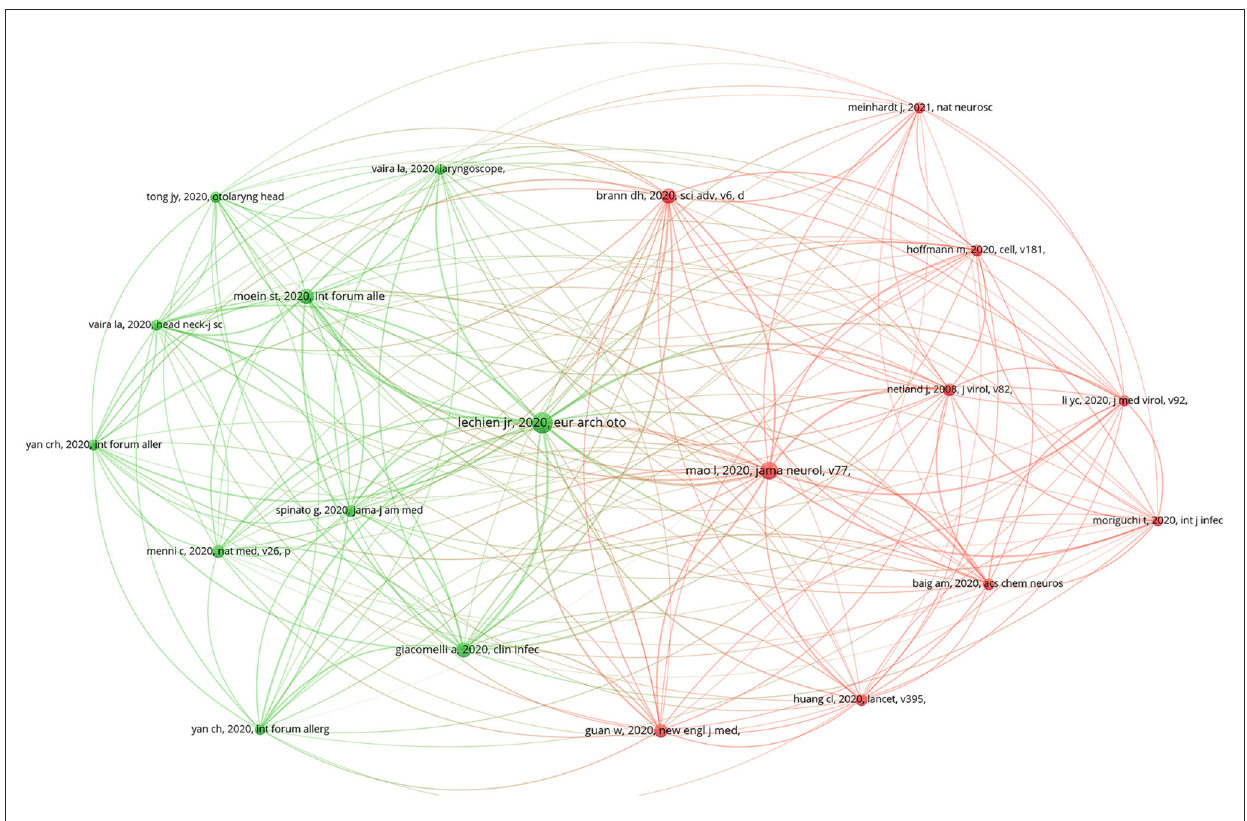
FIGURE3 The mapping of cited sources co-citation